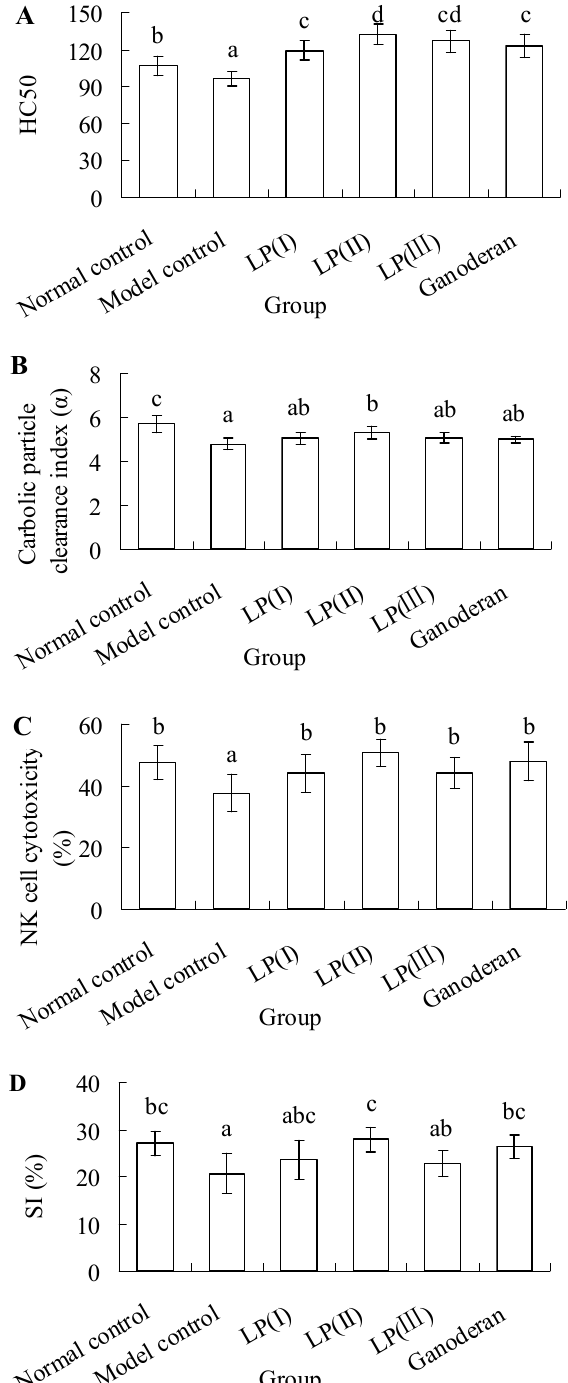
Figure 1. Effects of longan pulp polysaccharide-protein complex LP3 on ( A ) serum hemolysin production; ( B ) macrophages phagocytosis; ( C ) NK cell cytotoxicity; and ( D ) splenic lymphocyte proliferation. Data presented were means ± standard deviation (n =